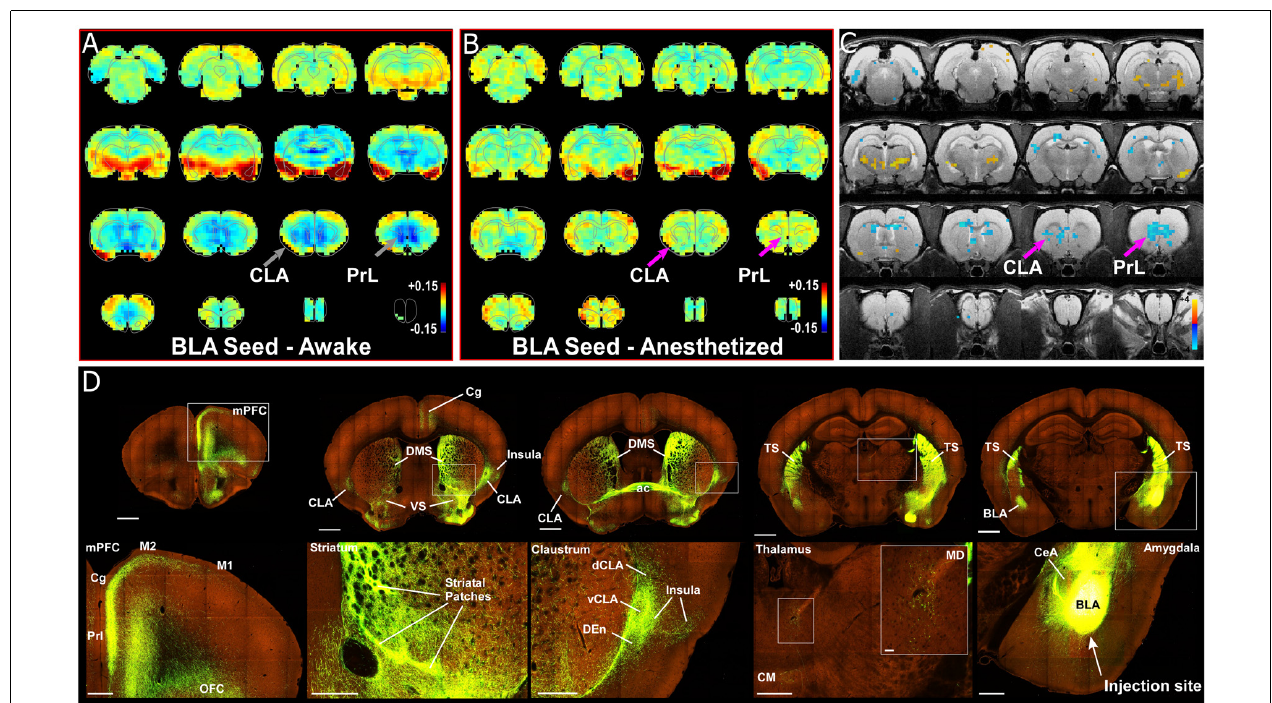
FIGURE 8 | Seed-based analysis and neuroanatomical tracing of basolateral amygdala (BLA) output reveal structural and anti-correlated functional connections with nodes in the SN. (A) Unilateral (left hemisphere, images shown in clinical orientation), seed-based analysis of BLA in the awake state. Color plots shown as before with hot colors indicating strong correlations and cool colors indicating anti-correlated blood oxygen level dependent (BOLD) activity. Note the widespread anti-correlation present between BLA and all of mPFC, sensorimotor cortex, dorsal thalamus, and striatum. (B) Unilateral, seed-based analysis of BLA in the awake state. Color plots shown as before. (C) Statistical map comparing the awake and anesthetized states (voxelwise two-way t -test), indicating an increase in correlation strength for functional connections from amygdala to prelimbic cortex (PrL) and claustrum (CLA) in the anesthetized state compared to the awake state (blue area identified by pink arrow). Hot colors show t -values for voxels with p < 0.05 (false discovery rate), which are significantly weakened in the anesthetized state compared to the awake. Cool colors indicate the reverse, meaning a significant decrease in anti-correlation under anesthesia compared to the awake state. (D) Data from the Allen Institute Mouse Connectivity Atlas (Oh et al., 2014) database demonstrate afferent projections from BLA to PrL, Cg, and insular cortices, as well as bilateral projections to striatum and CLA. Image credit: Allen Institute. Scale bars: 1 mm in top row of panel (D) ; 400 µ m in bottom row of panel (D) ; 40 µ m in thalamus inset in bottom row of panel (D)